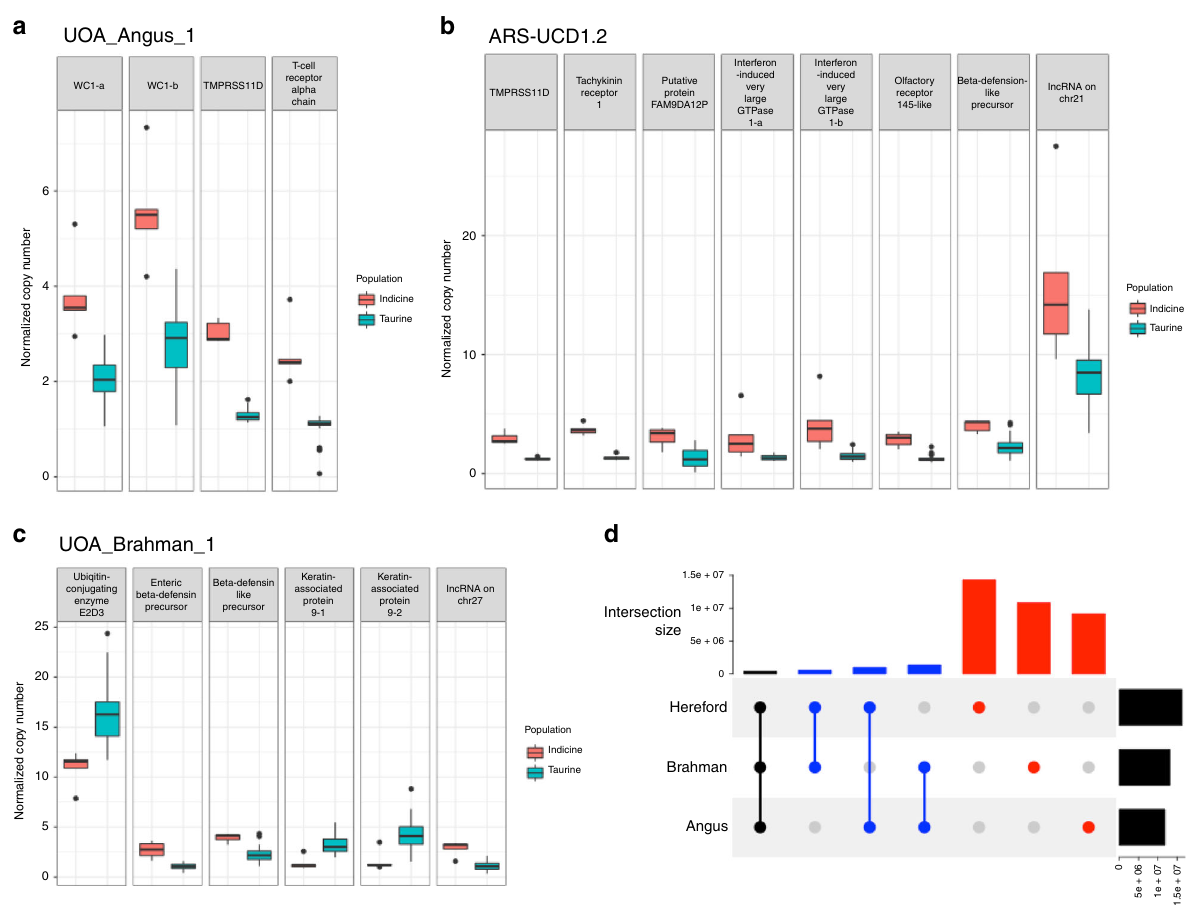
Fig. 5 Boxplot of normalized copy number of autosomal genes with V st > 0.3. Only those CNV genes with average copy number difference of at least 1.5 copies between the taurine and indicine groups are shown. Dot plots of individual values are overlaid on top of boxplots to show minima and maxima as circles. The bounds of box show the 25th and 75th percentile, with the median drawn as a thick line between these two quartiles. The reference genomes were a UOA_Angus_1, b ARS-UCD1.2, and c UOA_Brahman_1. d Liftover of CNV regions from Brahman and Angus to Hereford ARS-UCD1.2 common coordinate for an assessment of intersection between them at base-pair